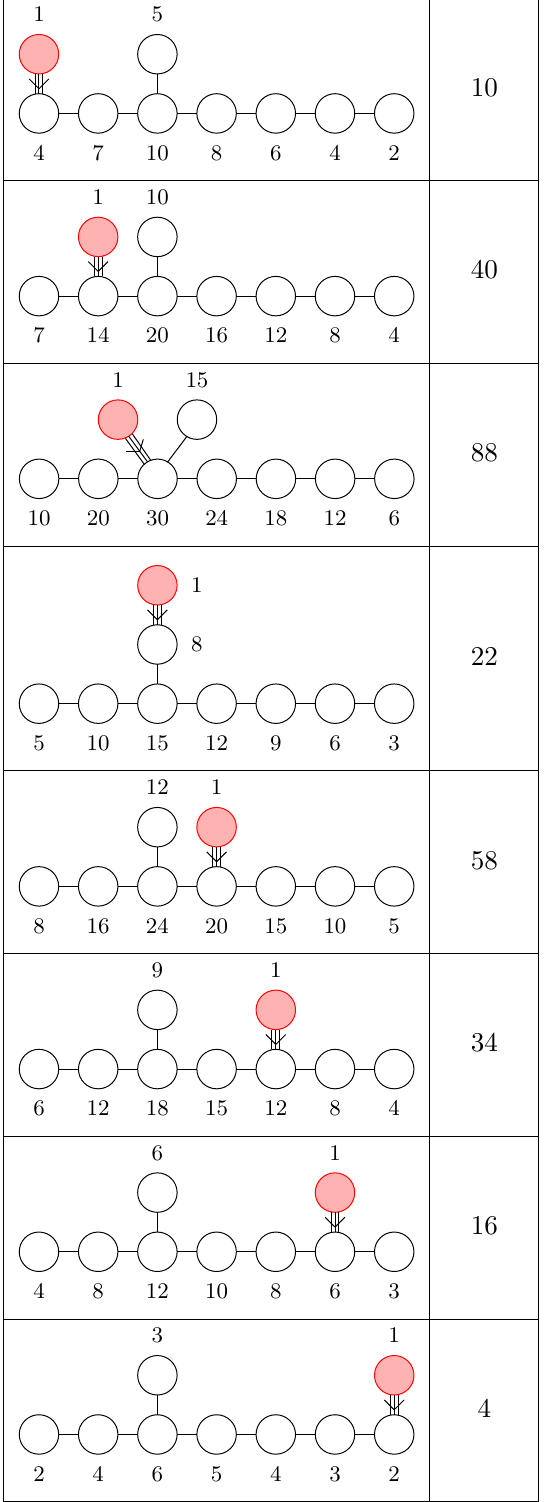
Table 26 . Exotic minimally unbalanced quivers of E 8 -type with outward triple laced